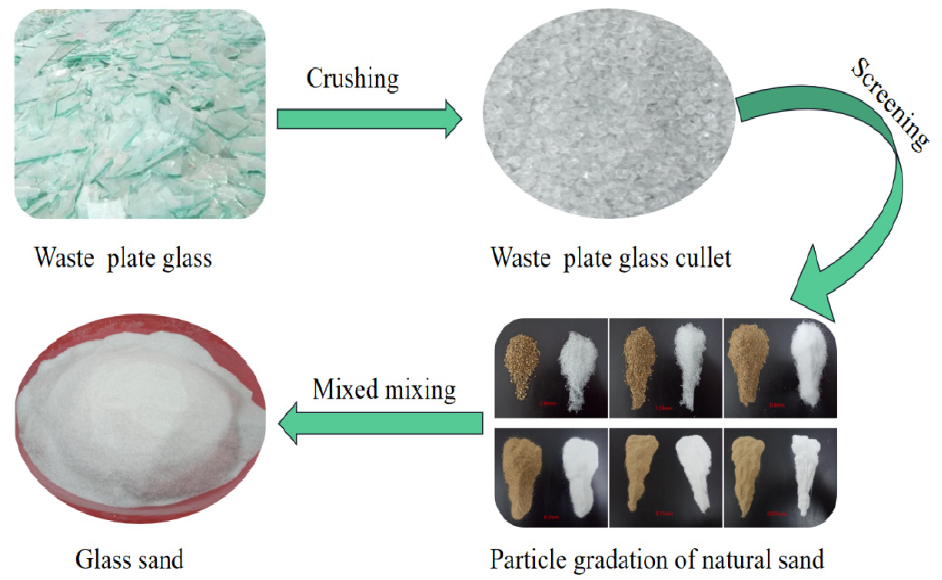
Figure 2. Waste glass sand production process.